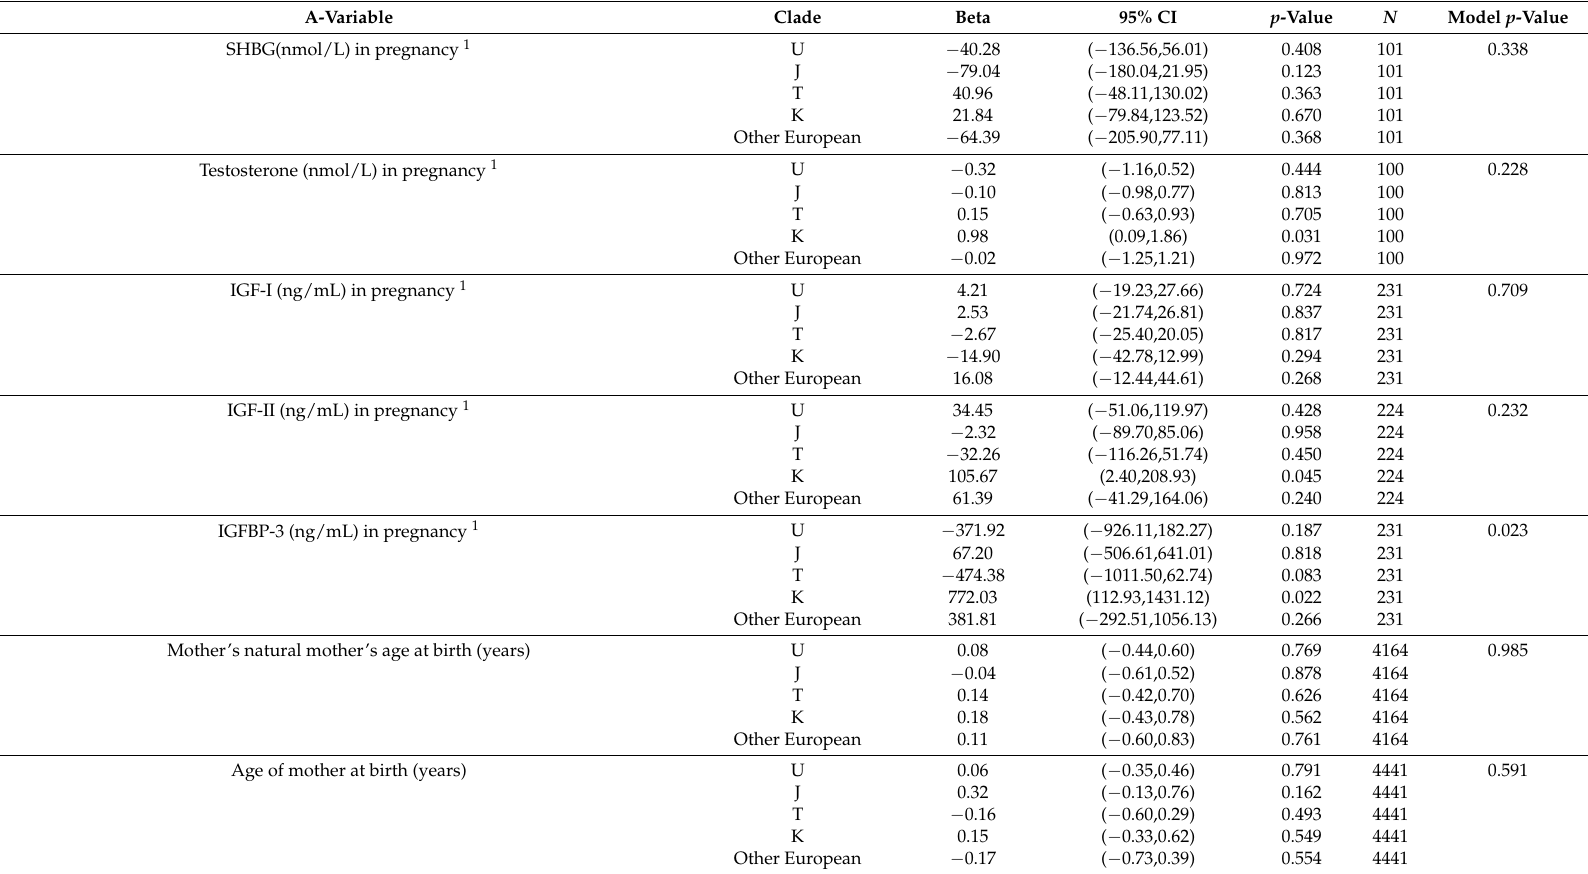
Table 2. Major European mitochondrial DNA (mtDNA) haplogroups and breast cancer risk factors in ALSPAC mothers. Regression models adjusted for age and the top 10 genomic principal components. ( A ) Continuous variables; ( B ) categorical variables. Reference is haplogroup